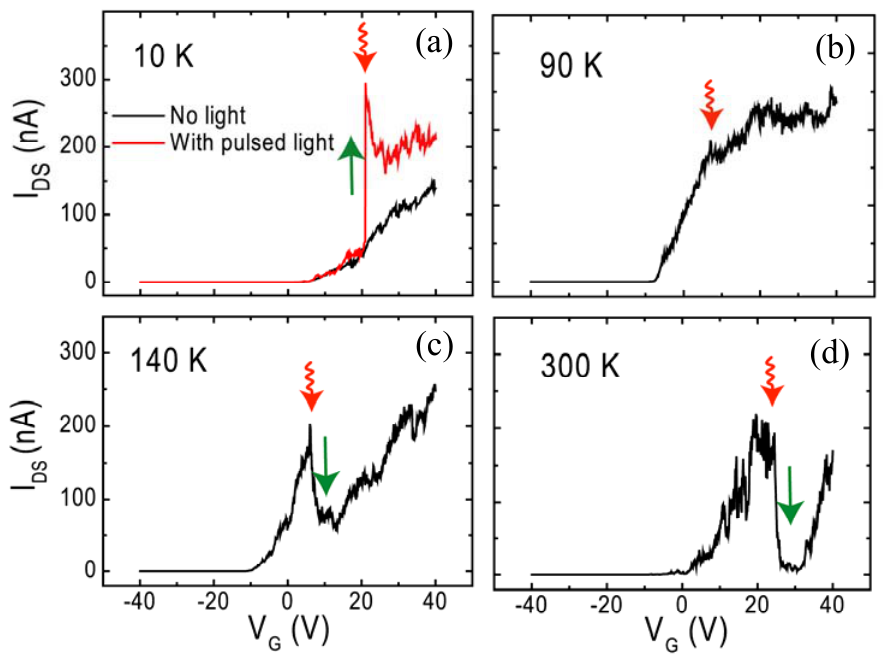
Figure 7. Photoinduced currents observed during tracing the I pulse at ( a ) 10 K, ( b ) 90 K, ( c ) 140 and ( d ) 300 K,